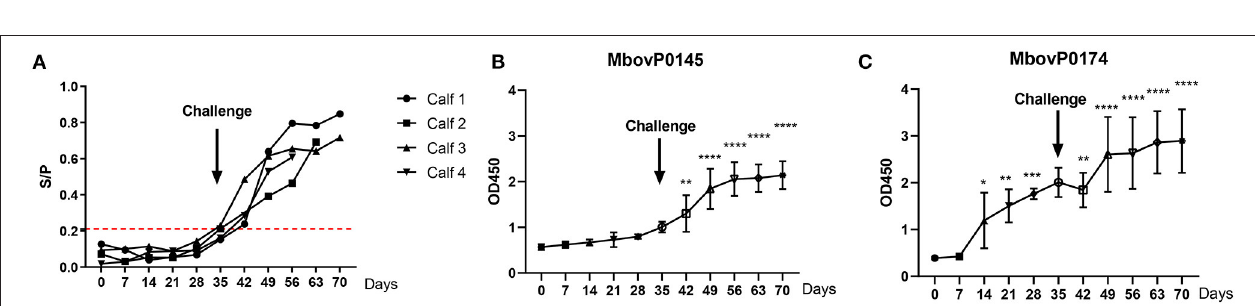
FIGURE 7 | Evaluation of the rMbovP0145-based iELISA for the detection of an IgG response to Mycoplasma bovis infection. (A) Comparison of serum antibody detection with rMbovP0145-iELISA from naturally infected, experimentally infected, and uninfected cattle groups. The cutoff for the sample-to-positive (S/P) value was determined as 0.211 when the overall diagnostic sensitivity and specificity were 97.0 and 98.7%, respectively. The bar indicates the mean of each group, and the dashed line indicates the cutoff point. The diagnostic sensitivity of 98.7% (95% CI: 93.1–99.8%) and specificity of 97.5% (95% CI: 87.1–99.6%) for the natural infection are significantly higher than the sensitivity of 89.7% (95% CI: 81–94.7%) and specificity of 90% (95% CI: 79.9–95.3%) for the experimental infection (** p < 0.01). Both two groups were significantly higher than the negative controls, respectively (**** p < 0.0001). (B) Receiver operating characteristic analysis of the rMbovP0145-iELISA.